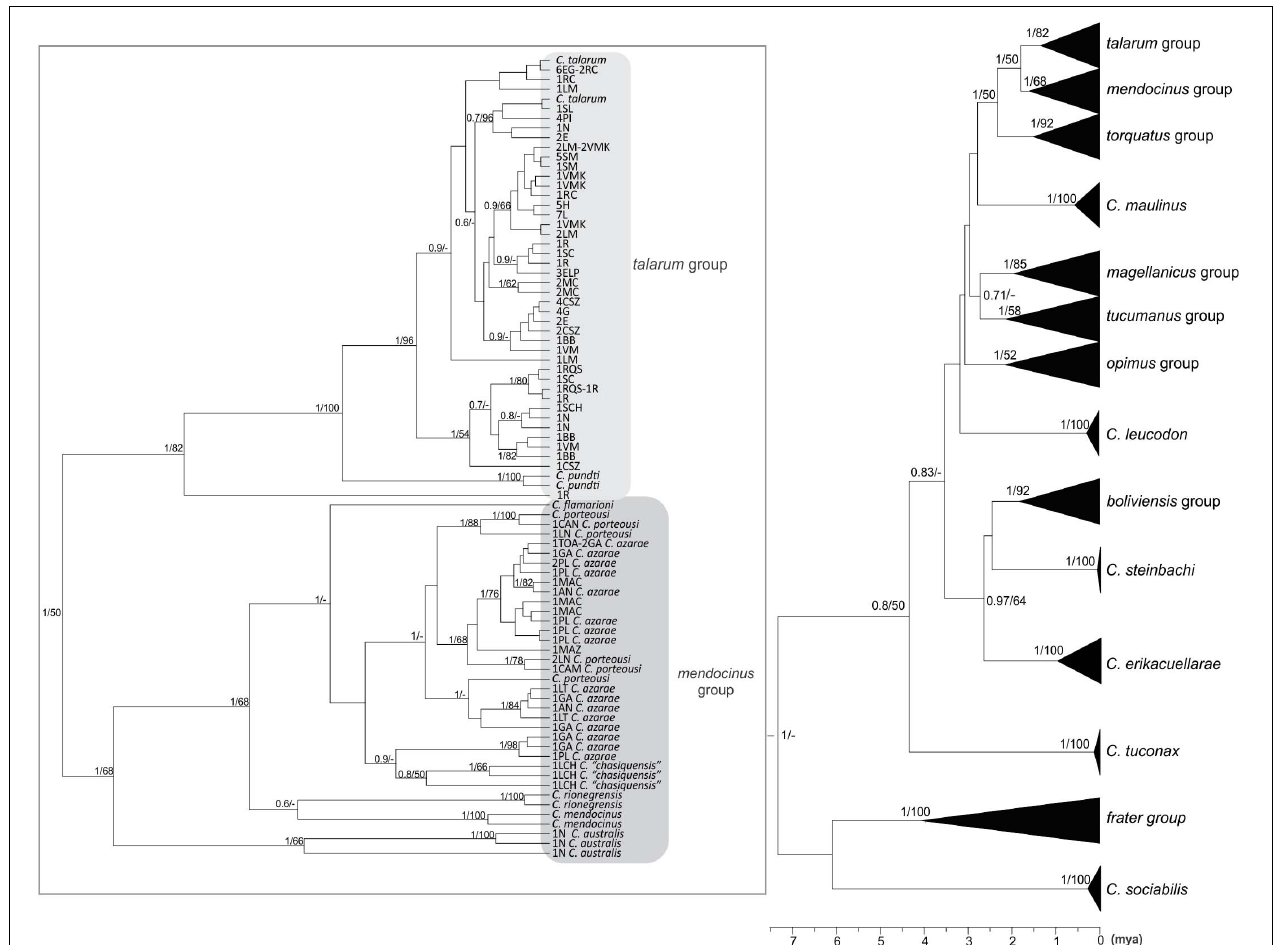
FIGURE 2 | Phylogenetic tree using a Bayesian Inference from the complete cyt- b data set (1,140 bp). The numbers in nodes represent the values of node support in the Bayesian (between 0 and 1) and Maximum Likelihood (between 0 and 100) inferences. Values greater than 0.5 and 50 for Bayesian and Maximum likelihood inferences are shown, respectively. The bottom bar indicates the time from the root of the tree to the present time expressed in million years ago (mya). Clades belonging to talarum and mendocinus groups are shown in the left. Terminals represent different haplotypes, each with the abbreviations of populations to which it belongs, and its frequency, as well as the species to which it was previously assigned (if applicable). The abbreviations of sampling locations to which each sequence belongs are detailed in Table 1 and the detail of sequences extracted from GenBank database is indicated in Table 3